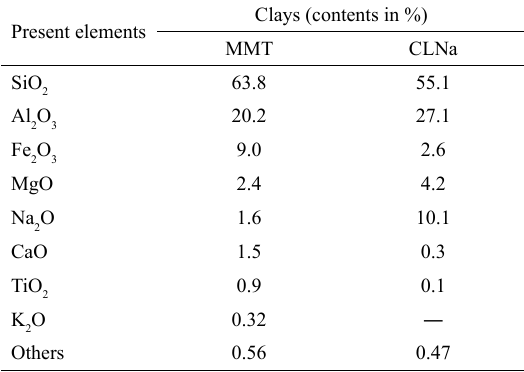
Table 3. Chemical analysis by X-ray fluorescence of Brasgel PA and Cloisite Na clays.